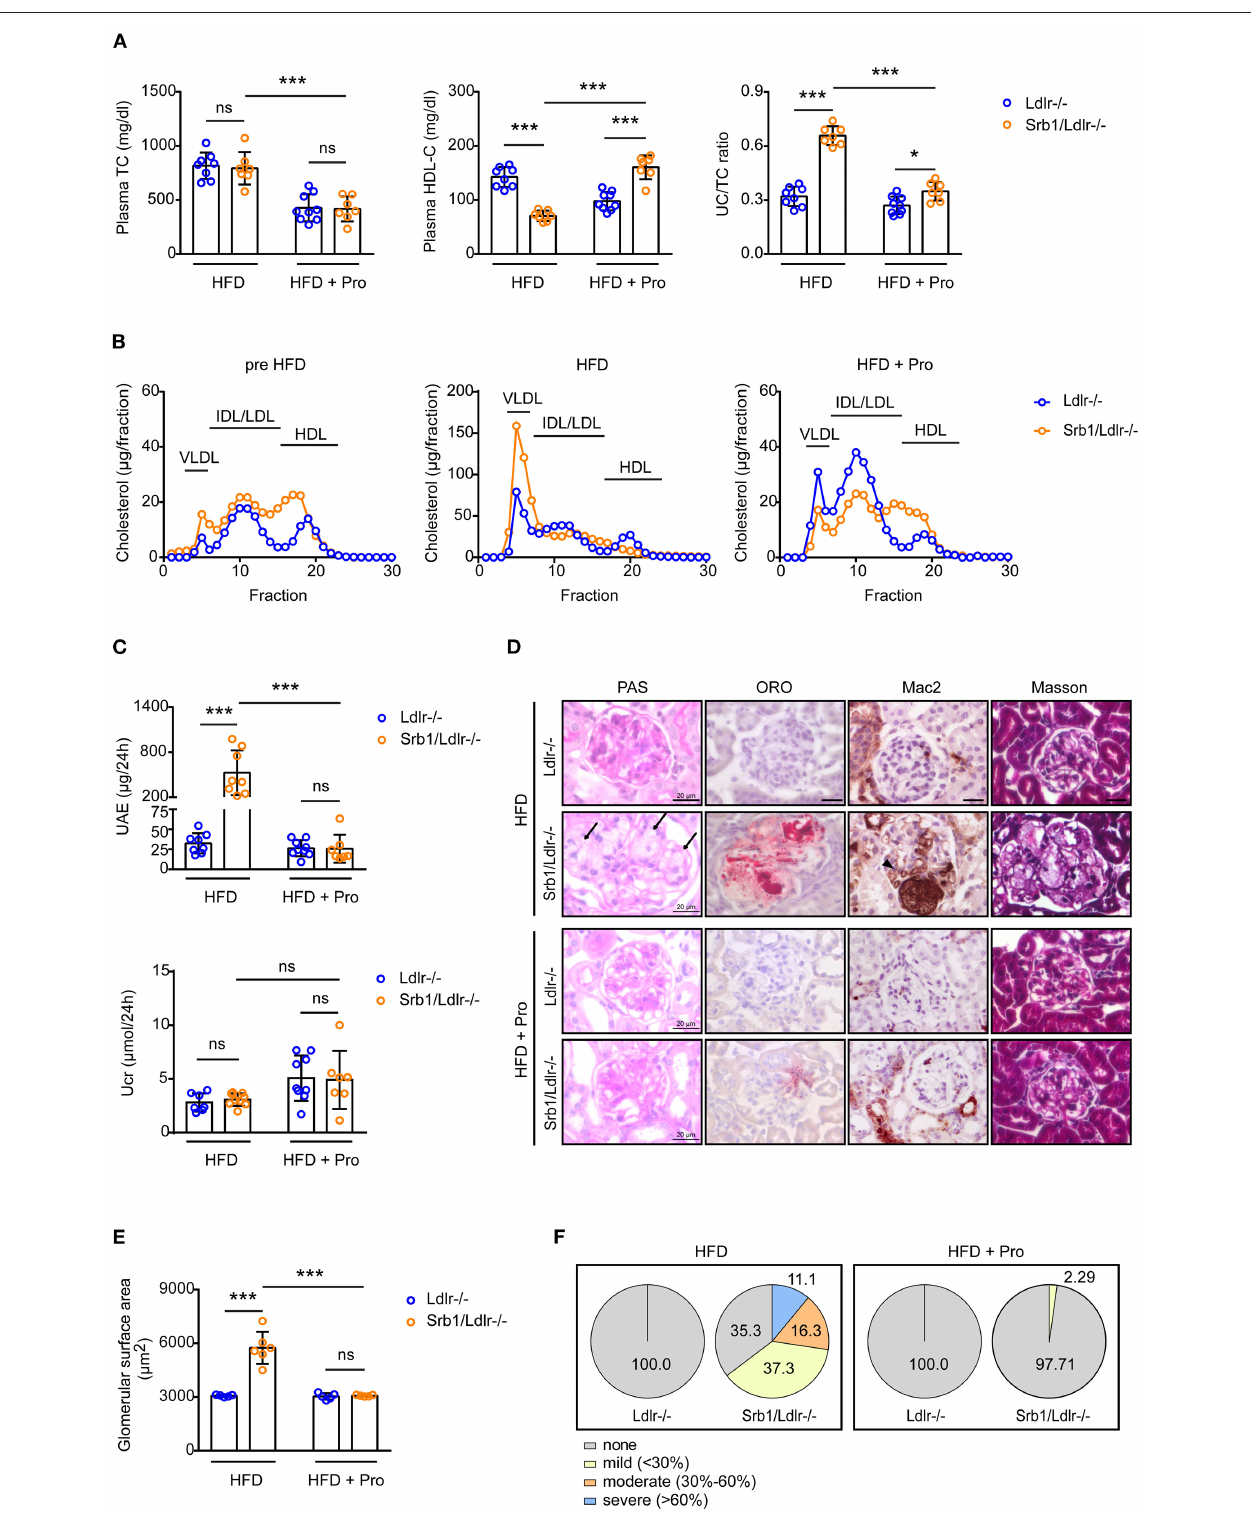
FIGURE 4 | Plasma lipid parameters and renal function/histology in Srb1/Ldlr-/- and Ldlr-/- mice fed on HFD as well as HFD with probucol (Pro) supplement. (A) Plasma TC levels, HDL-C levels and UC/TC ratios; (B) Lipoprotein profiles fraction by FPLC; (C) 24-h UAE and Ucr; (D) Representative glomeruli stained with PAS, ORO, Mac2, and Masson. The arrows indicate foam-like lipoproteins. The triangle indicates macrophages; (E) Glomerular surface area; (F) Quantitation of ORO-positive lipoprotein deposition. n = 5–9 per group. * : p < 0.05; *** : p < 0.001; ns: no significance.